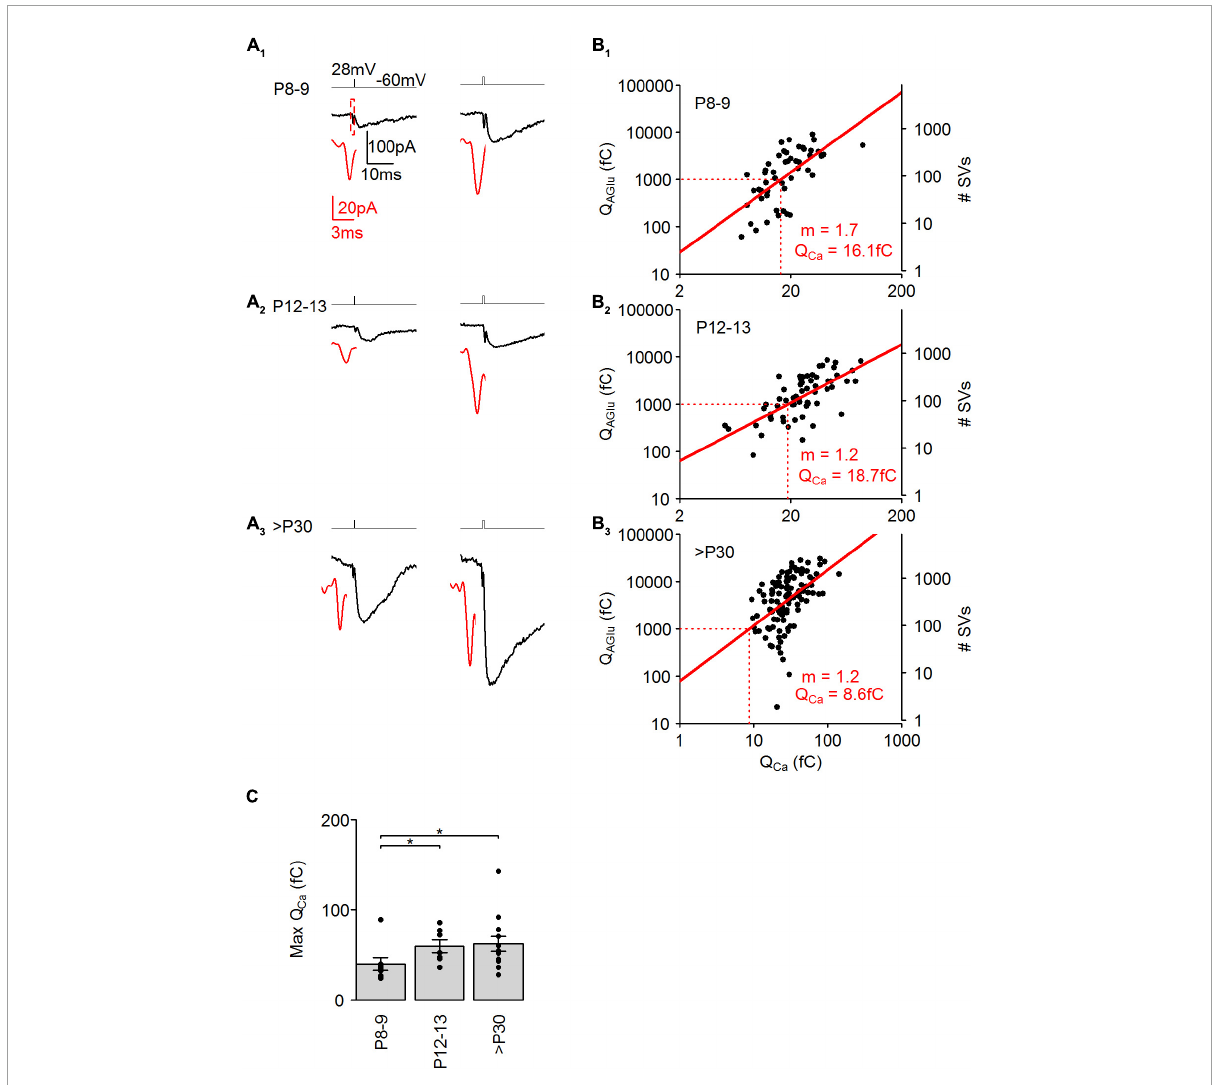
FIGURE7 Postnatal development of Ca 2 + dependence at cone photoreceptors. (A 1 - 3 ) Representative I AGlu events evoked by either a 0.38–0.56 ms (left) and 1 ms (right) step depolarization (from –60 to 28 mV). Black traces show the I AGlu events and red traces show an expanded view of I Ca preceding the I AGlu events. (B 1 - 3 ) Plot of the charge transfer of Q Ca against the charge transfer of I AGlu on a log-log axis. Red lines show linear regression fits of log transformed data. m = slope of fitted line. Red dashed lines indicate Q Ca at Q AGlu = 1,000 fC. Linear fits were significant at all developmental stages [(P8–9: y = 1.7x + 0.958, r 2 = 0.426, p < 0.001, n = 51 events from 7 cells), (P12–13: y = 1.2x + 1.434, r 2 = 0.472, p < 0.001, n = 61 events from 9 cells), ( > P30: y = 1.2x + 1.897, r 2 = 0.235, p < 0.001, n = 116 events from 13 cells)]. (C) Charge transfer of I Ca for a step depolarization (1 ms, –60 to 28 mV) at the different developmental stages ( p = 0.0264, Kruskal-Wallis Test). Post hoc Mann-Whitney U -test (P8–9 vs. P12–13: p = 0.043, P8–9 vs. > P30: p = 0.038, P12–13 vs. > P30: p =